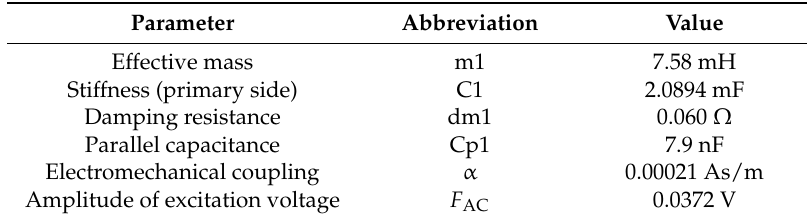
Table 1. Nominal parameters of the equivalent circuit for the piezoelectric cantilever (PEC) tuned to the resonance frequency of 40